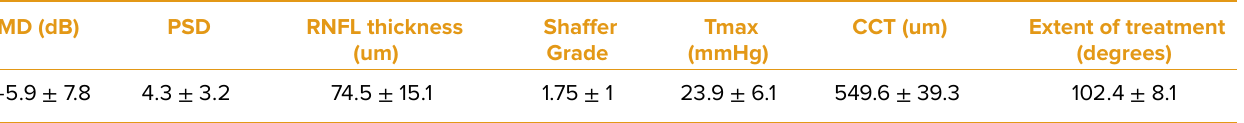
Table 3. Comparison of IOP and medications pre- and post-BANG Pre-op POM 1 POM 3 POM 6 Mean IOP Meds Mean IOP Meds Mean IOP Meds (mmHg) (mmHg) (mmHg) 17.4 ± 4.1 P